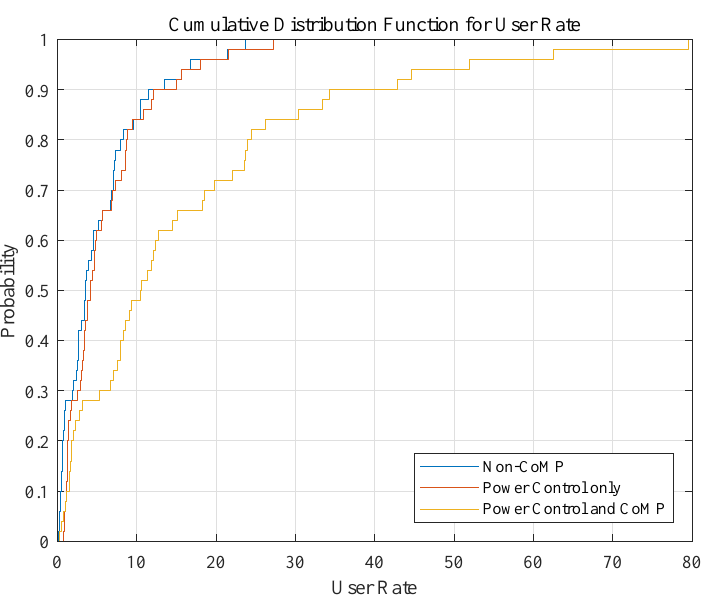
Figure 5. Average cluster size and the number of clusters.